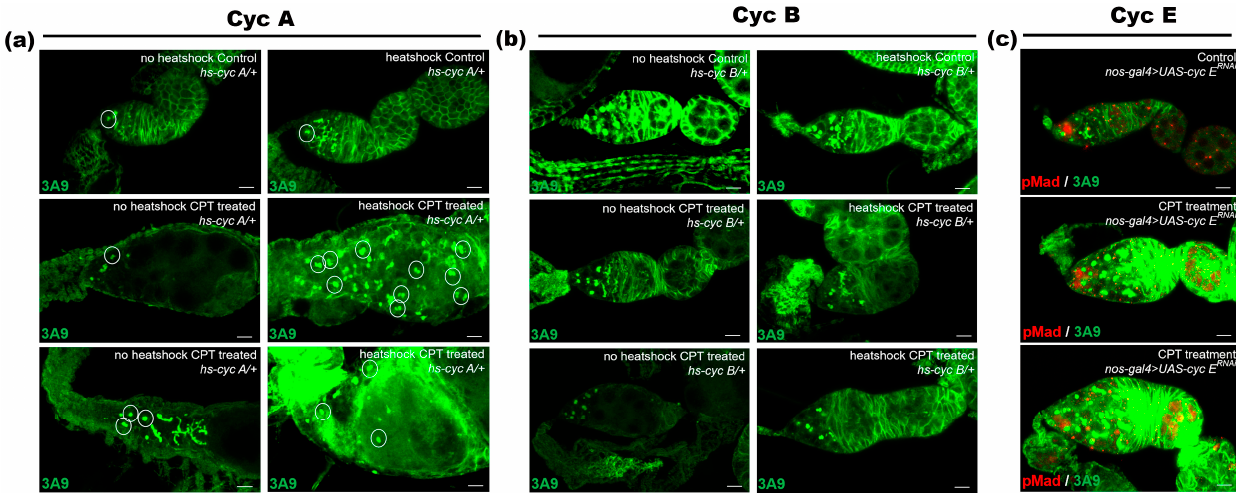
Figure 7. CycA was involved in CPT-induced GSC loss and two-cell accumulation. ( a ) Control and CPT-treated female flies with or without exposure to heat shock to drive CycA expression and staining with anti-3A9 (green). ( b ) Control and CPT-treated female flies with or without exposure to heat shock to drive CycB expression and staining with anti-3A9 (green). ( c ) Control and CycE RNAi germarium and stained with anti-pMad (red) and anti-3A9 (green).